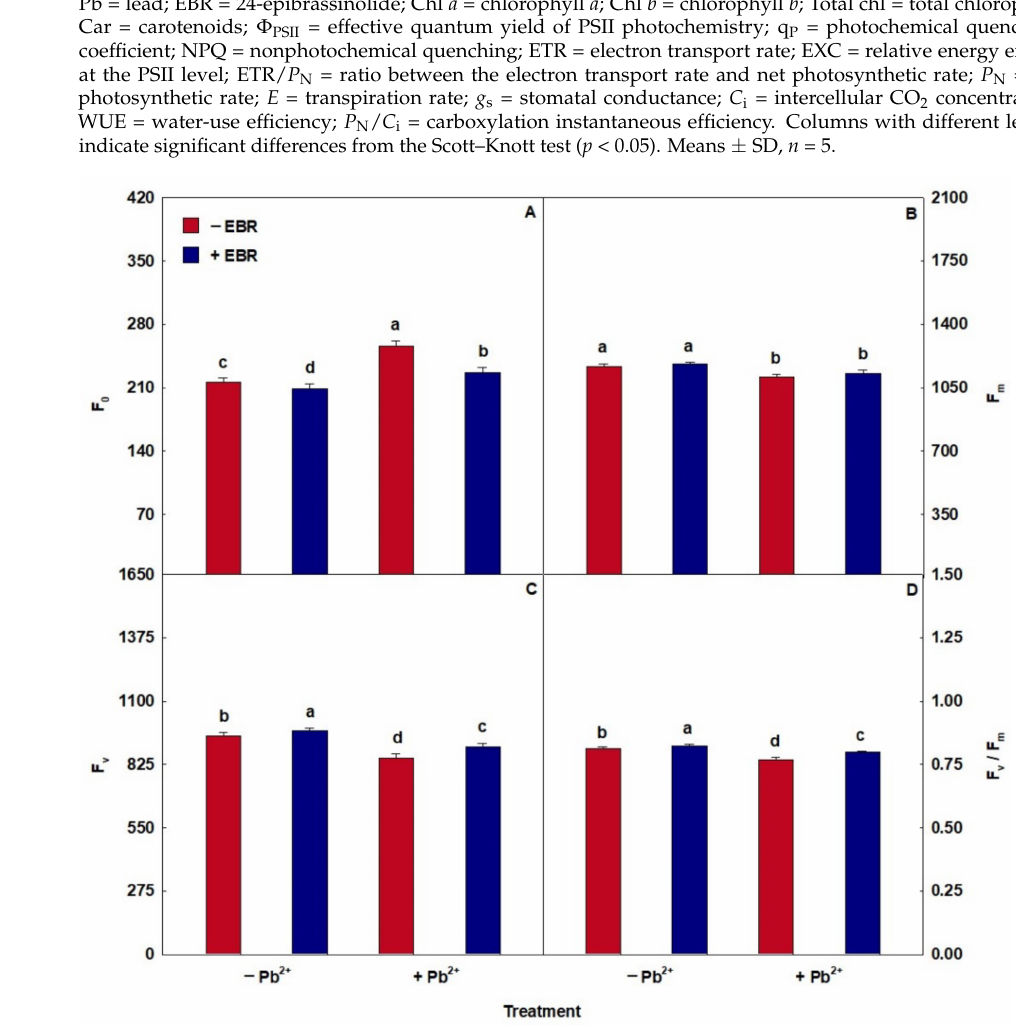
Figure 4. ( A ) Minimal fluorescence yield of the dark-adapted state (F 0 ), ( B ) maximal fluorescence yield of the dark-adapted state (F m ), ( C ) variable fluorescence (F v ), and ( D ) maximal quantum yield of PSII photochemistry (F v /F m ) in tomato plants treated with 24-epibrassinolide (EBR) and subjected to lead (Pb) toxicity. Columns with different letters indicate significant differences from the Scott–Knott test ( p < 0.05). Means ± SD, n =